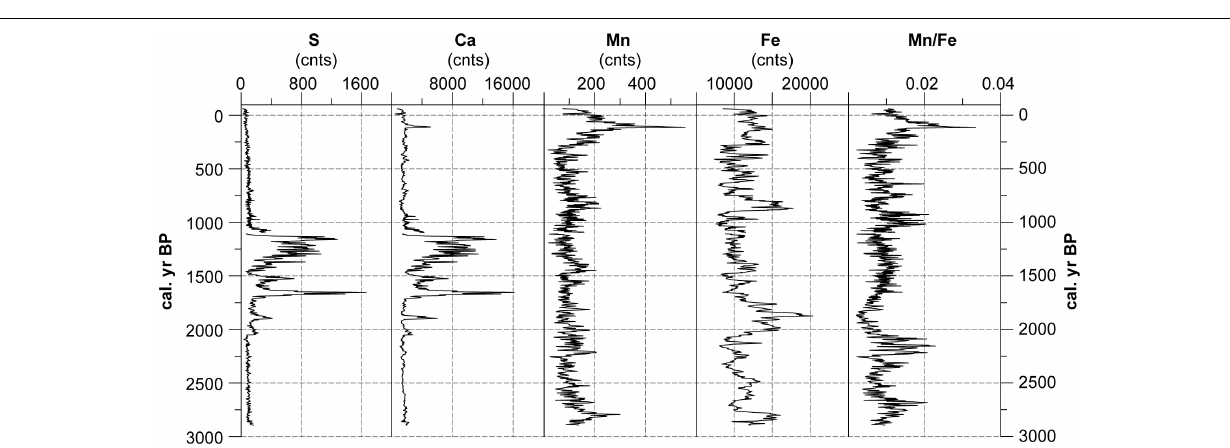
FIGURE 6 | Results of XRF analyses. Given are S, Ca, Mn and Fe values as well as the Mn/Fe-ratio. Missing values are due to the hiatus between 1080 and 1110 cal. yr